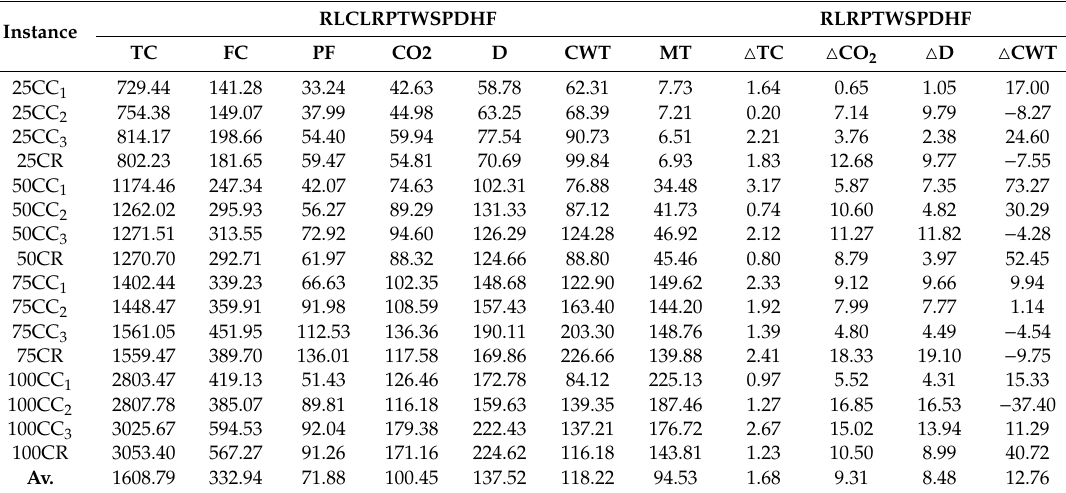
Table 4. Results of two models on